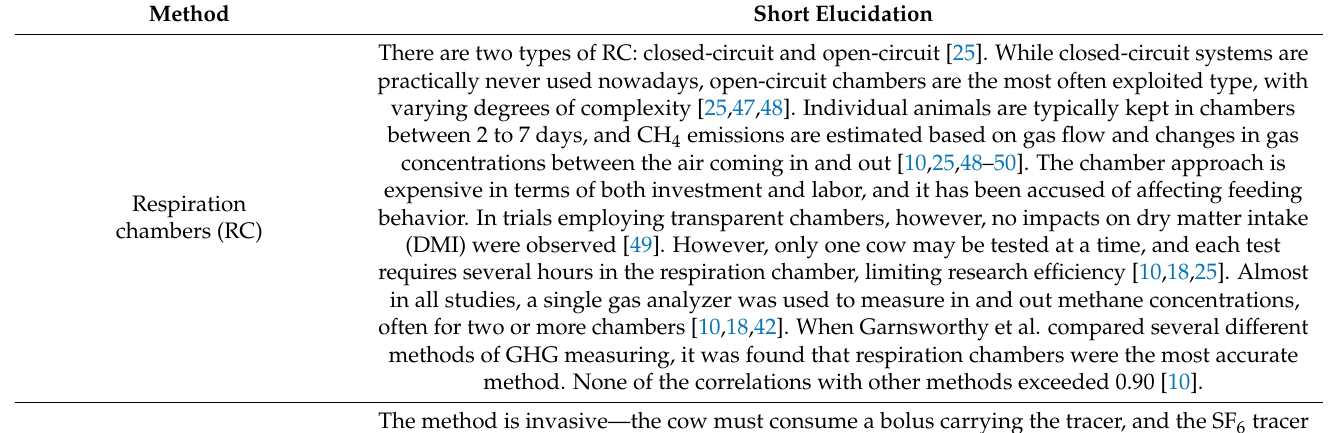
Table 1. Methods for measuring CH 4